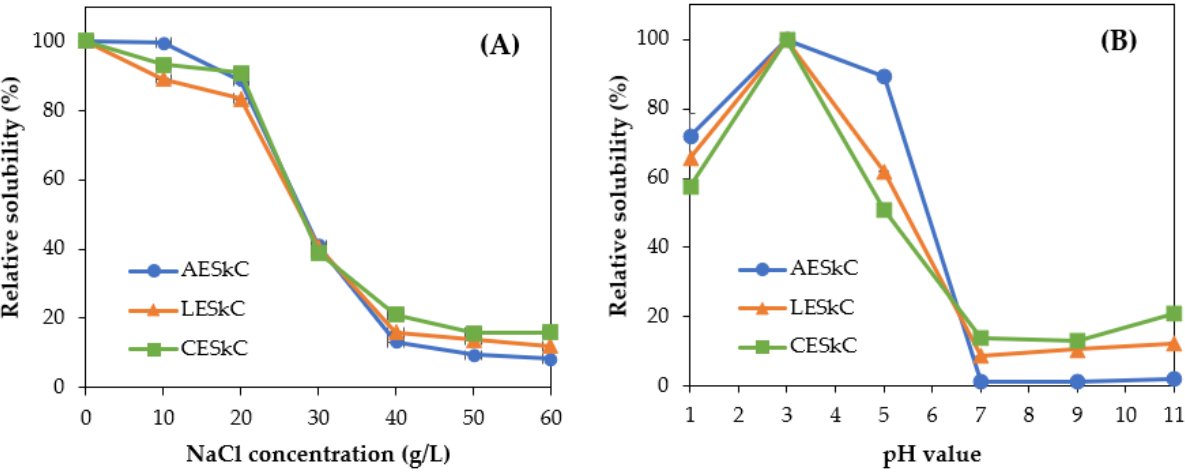
Figure 7. Solubility evaluation of lizardfish skin collagens extracted with different acids. ( A ) at different pH level and ( B ) at NaCl treatment. AESkC: acetic acid-extracted collagen; LESkC: lactic acid-extracted collagen; CESkC: citric acid-extracted collagen.